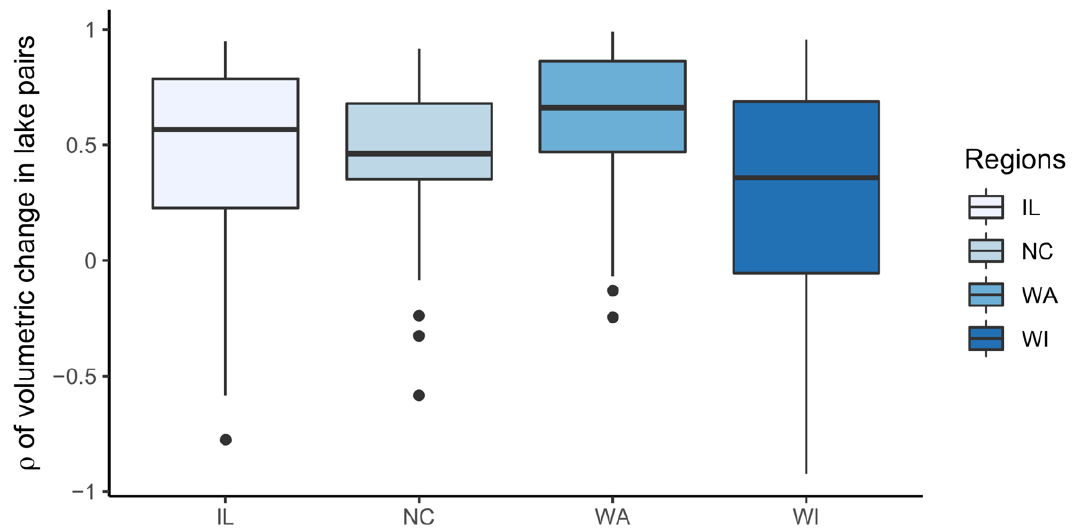
Figure 10. The distribution of correlation coefficients ( ρ ) between change in lake water volume for all lake pairs in each region. The boxes represent the distribution of the correlation coefficients to the upper and lower quartiles. The whiskers represent the full range of the correlation coefficients to the minimum and maximum, with the points being outliers in the data set.